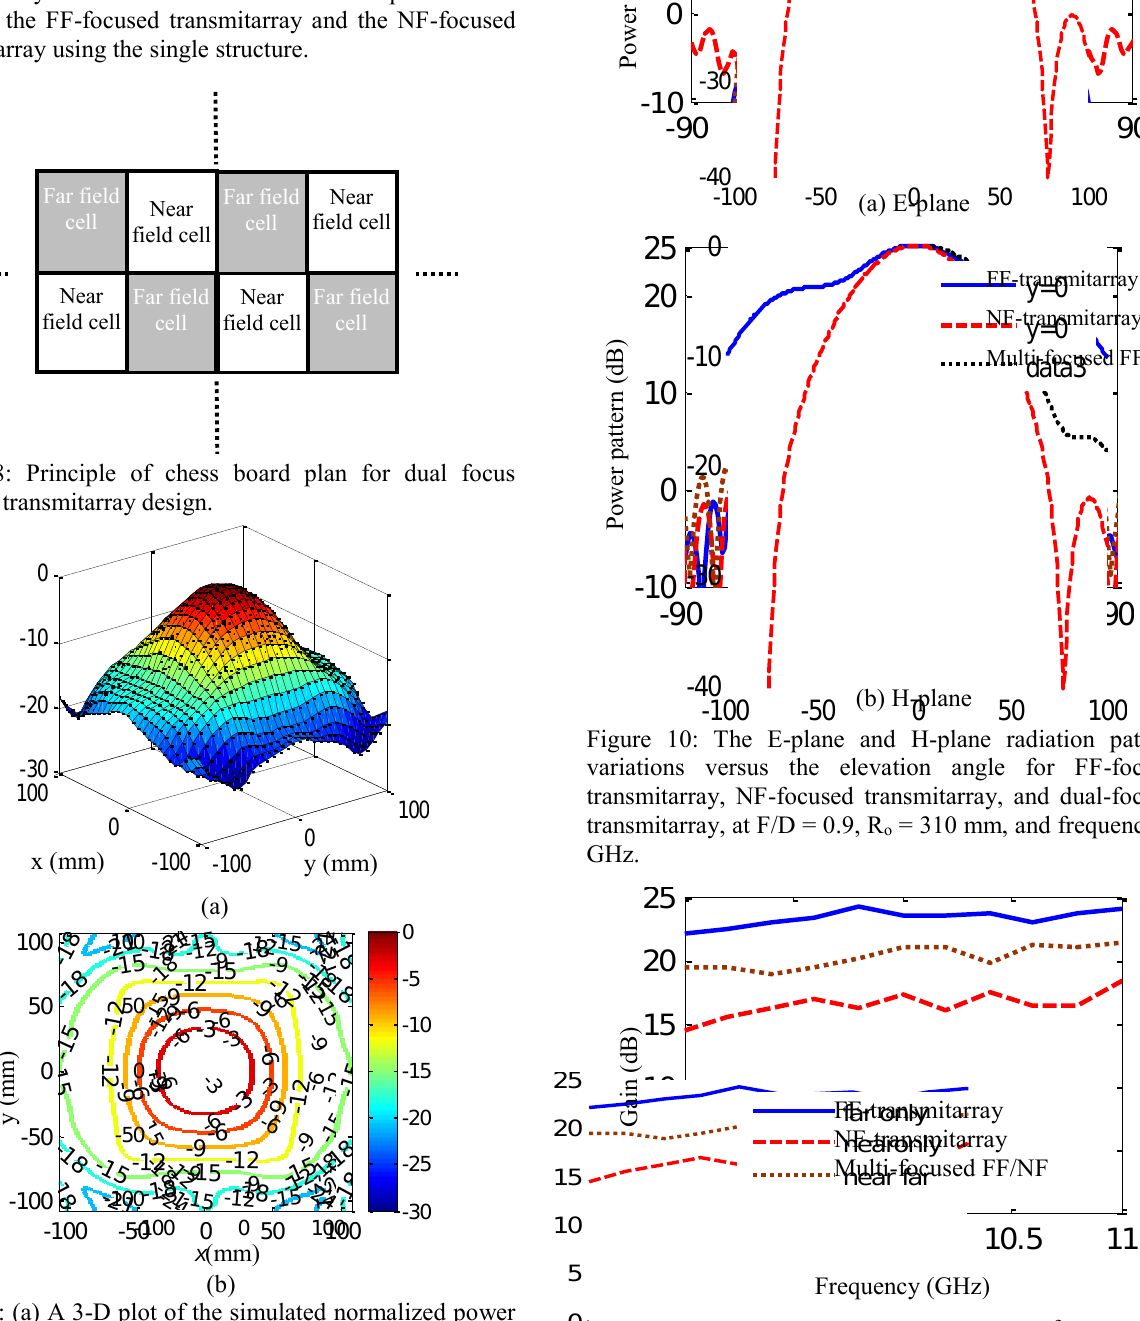
Figure 11: The variations of the gain versus frequency for FF-focused transmitarray, NF-focused transmitarray, and dual-focused transmitarray at F/D = 0.9, R o = 310 mm, and frequency 10